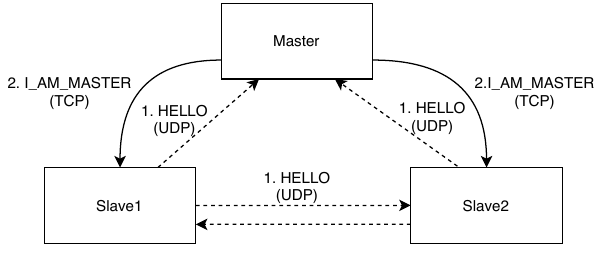
Figure 2. Discovery process message exchange.